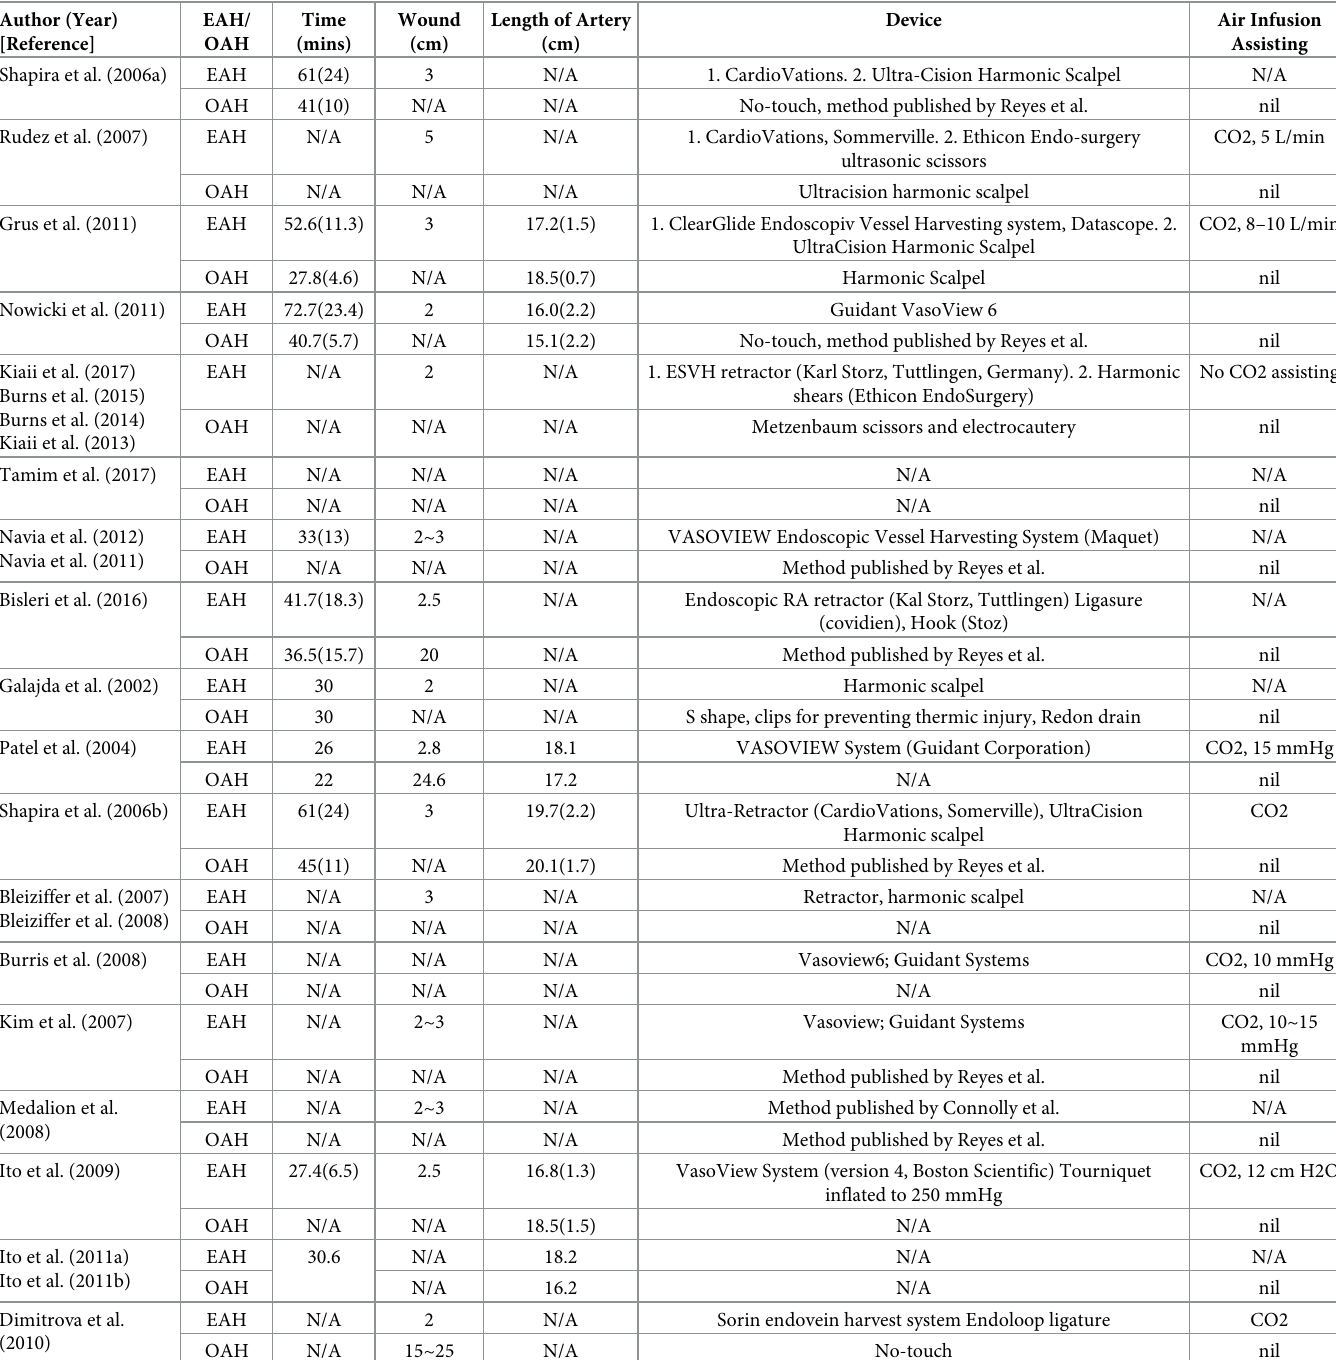
Table 3. Operation details of included